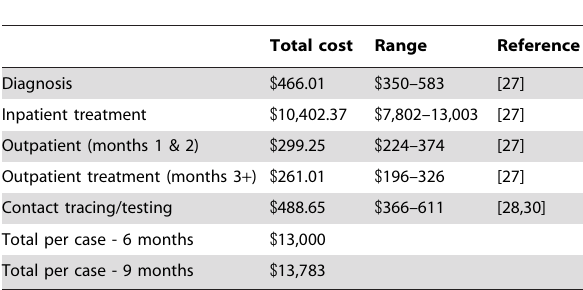
Table 4. Costs in US $ associated with treating active